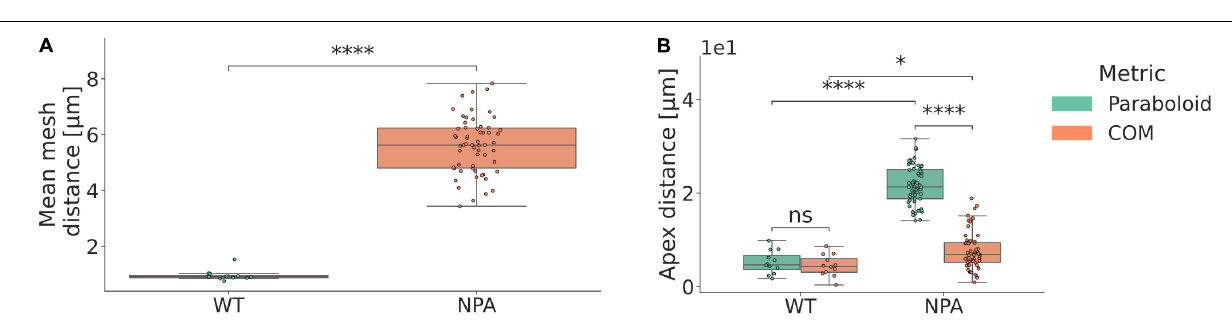
FIGURE 2 | Local shoot meristem growth is well approximated by a paraboloid. (A) Mean euclidean mesh distance in terms of identification of the closest vertex on the paraboloid, for every point in the surface mesh. Paraboloids are good approximations of the inflorescence tissue shape in WT plants. µ WT = 0.96 µ m; µ NPA = 5.62 µ m; d = 4.66 µ m; p = 5.84e-08 ( ∗∗∗∗ ); n WT = 12; n NPA = 59; where µ represents the mean, d the corresponding difference between the means, and n the number of samples per category. (B) Euclidean distance between the identified apices, using either the fitted paraboloid (para), or the inflorescence centre of mass (COM). Paraboloid and centre of mass methods accurately predict the CLV3 peak expression domain. µ WT , para = 5.19 µ m; µ NPA , para = 21.69 µ m; d para = 16.50 µ m; µ WT , COM = 4.51 µ m; µ NPA , COM = 7.72 µ m; d COM = 3.21 µ m; p WT = 1.00 (ns); p NPA = 2.65e-19 ( ∗∗∗∗ ); p para = 2.33e-07 ( ∗∗∗∗ ); p COM = 2.1e-02 ( ∗ ). The centre of mass, paraboloid apex and CLV3 coordinates are projected onto the mesh using the paraboloid central axis for comparison purposes. See Methods and Supplementary Figure 4 for further descriptions of the apex quantification